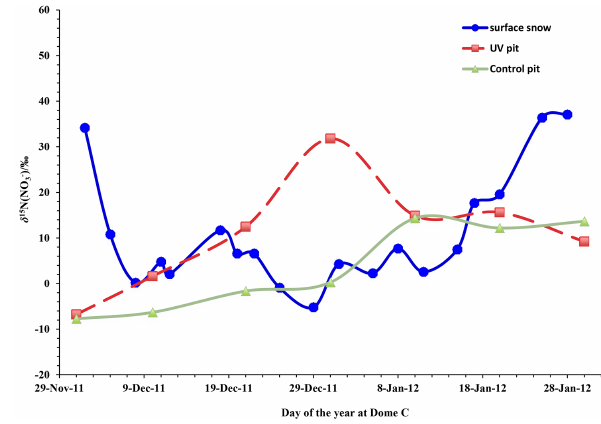
Figure 6. δ 15 N time series for nitrate in natural surface snow com- pared to surface snow sampled from the UV and control